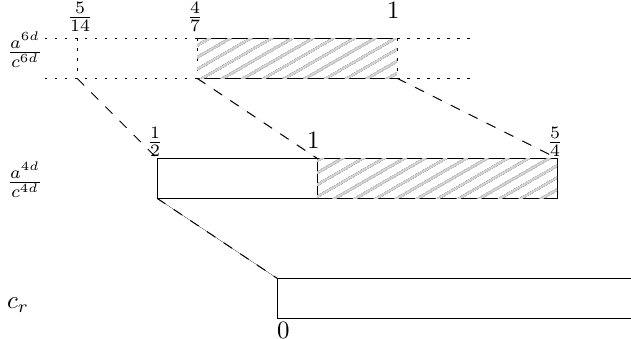
Figure 2 . Mapping of various values of a=c under (3.15) from 6d N = (2 ; 0) to a 4d N = 2 theory. The map to 2d, either by the (cid:11) -twist (3.31) or the (cid:12) -twist (3.35), relates the lower HM bound in 4d to the 2d unitarity bound c r (cid:21) 0 ( c l (cid:21) 0 is automatically